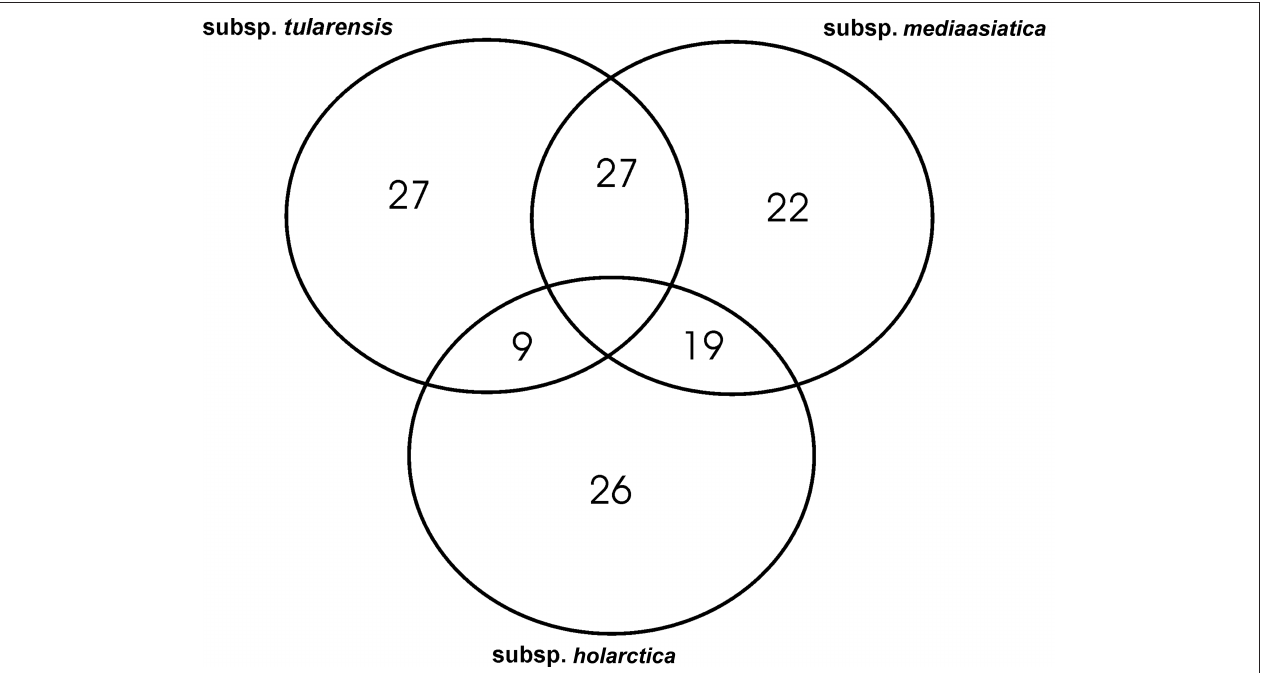
FIGuRE 1 | using 2D-PAGE coupled with mass spectrometric methods for protein identification, Hubalek et al. (2004) identified proteins that were unique to specific subspecies, or differentially expressed between